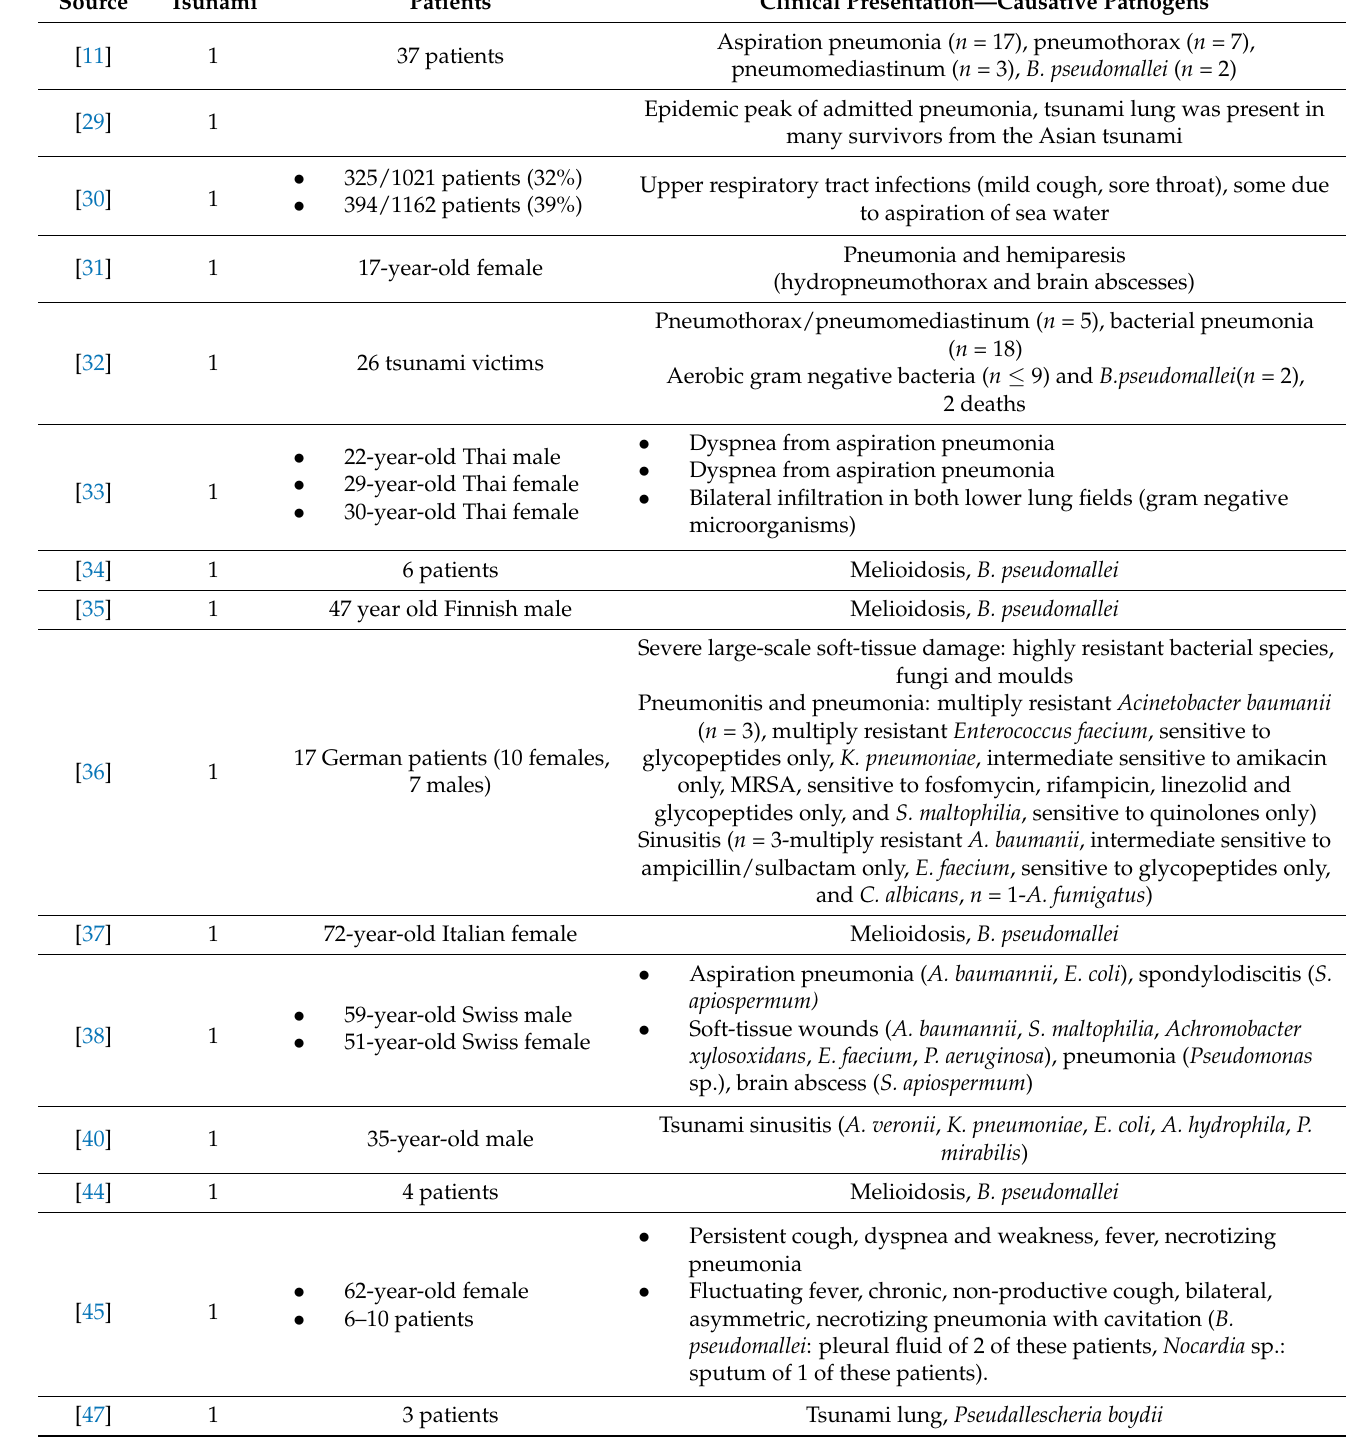
Table 1. Included studies referring to the occurrence of tsunami lung clustered by event and disease/pathogen reported. 1: the 2004 Indian Ocean tsunami, 2: the 2009 Samoa tsunami, 3: the 2011 Great East Japan tsunami. Source